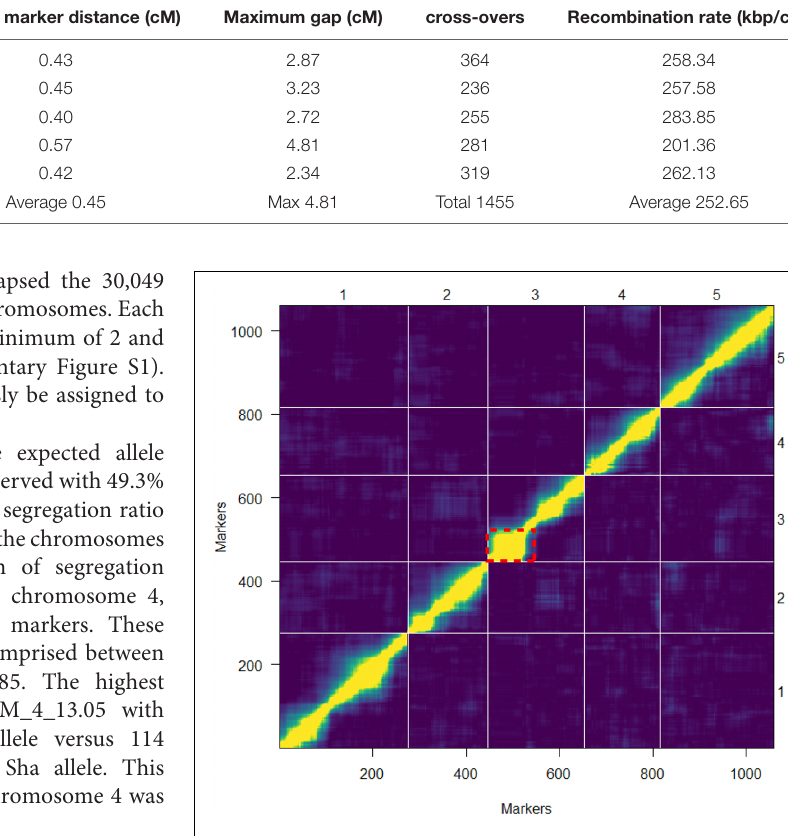
FIGURE 4 | Pairwise marker linkage analysis. The estimated recombination fraction and LOD scores for all pairs of markers are shown in the upper-left and lower-right triangle, respectively. High correlation between markers indicates marker linkage (yellow) while the blue color shows low correlation values indicating unlinked markers. The grid delineates the five chromosomes. The red dotted frame indicates the region at the top of chromosome 3 with the probable occurrence of an